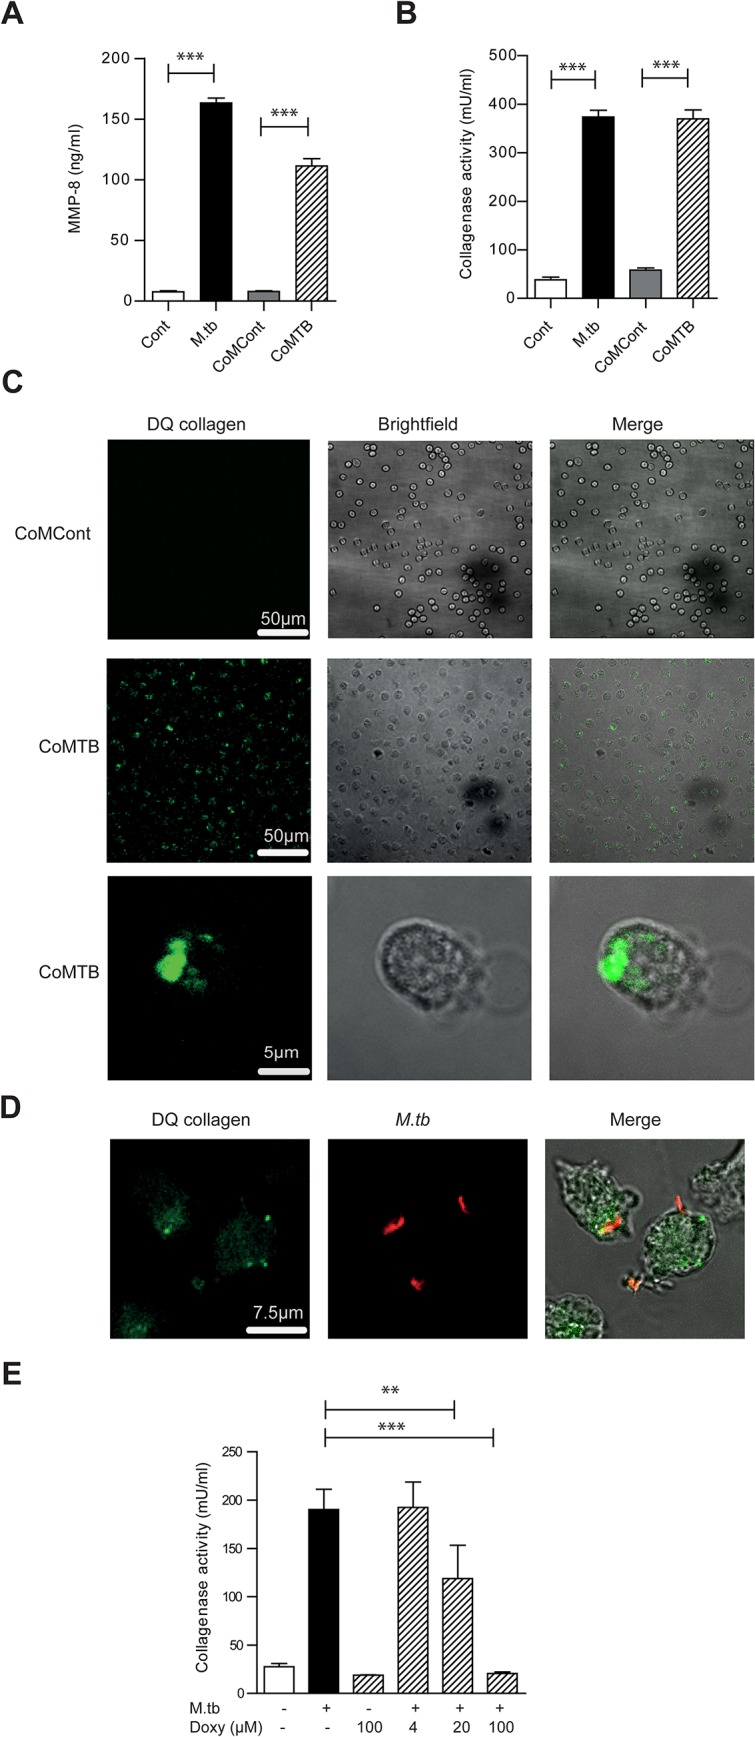

M.tb and CoMTB-stimulated neutrophils degrade collagen.(A) Neutrophils were stimulated with either M.tb MOI of 10, CoMCont or CoMTB for 4 hours. M.tb and CoMTB up-regulated MMP-8 secretion analyzed by ELISA. (B) Cell-free supernatants from (A) were incubated with Type I DQ collagen. Bars represent mean ± s.d. of experiments performed in triplicate and are representative of a minimum of 2 independent experiments. (C) CoMTB caused increased collagen breakdown by neutrophils, resulting in greater fluorescence of DQ collagen. (D) Neutrophils were infected with M.tb MOI 10, fixed and M.tb stained with anti-M.tb Ab. Infected cells degraded DQ collagen, increasing fluorescence. (E) Cell-free supernatants from neutrophils infected with M.tb at MOI 10 were added with doxycyline to Type I DQ collagen. Doxycycline suppressed collagenase activity in a dose-responsive manner. Bars represent mean ± s.d of an experiment performed in biological triplicates and represents 2–3 independent experiments. Analysis performed using One-way ANOVA with Tukey’s post-test. ** P<0.01, ***P<0.001.